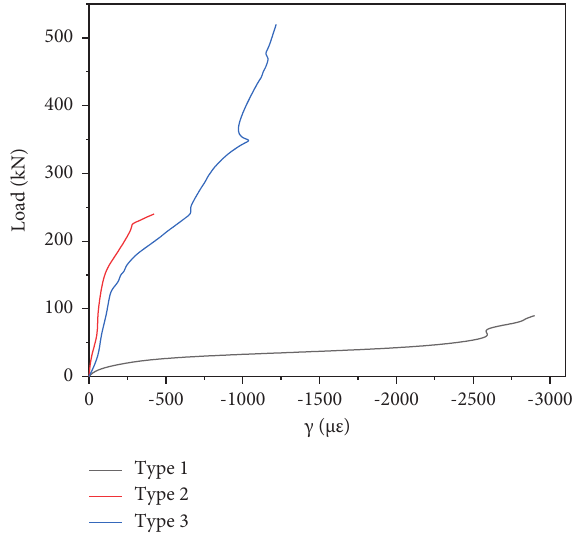
Figure 12: Load-shear strain curves of wet joints. Note. c is the shear